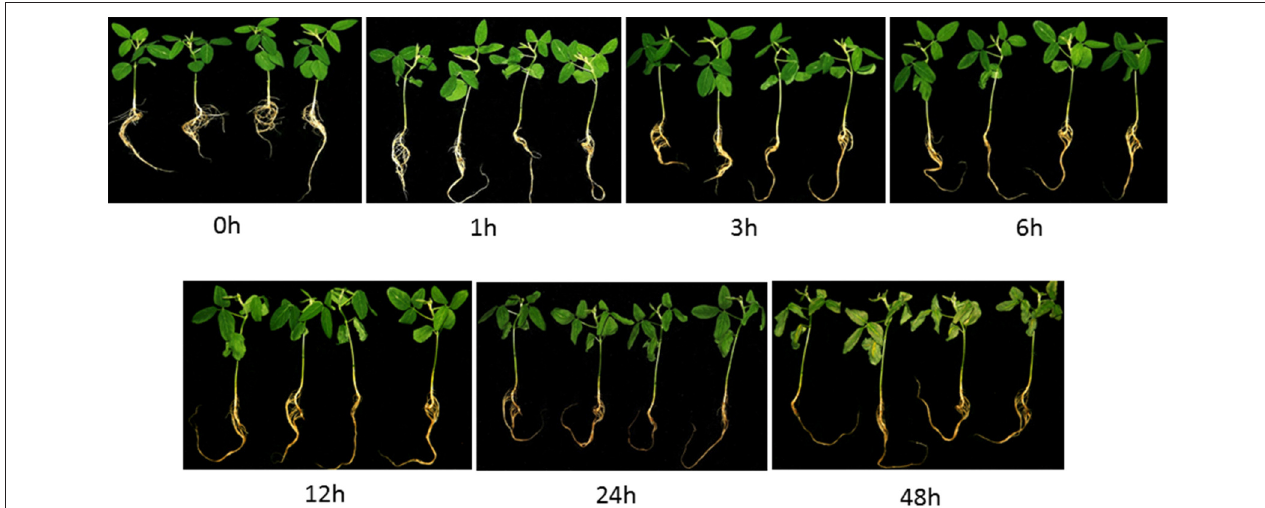
FIGURE 1 | Morphological changes of soybean seedlings after treatment with 200 mM NaCl for 0, 1, 3, 6, 12, 24 and 48h. The photographs showed similar plants at the indicated time points which were representative of three independent